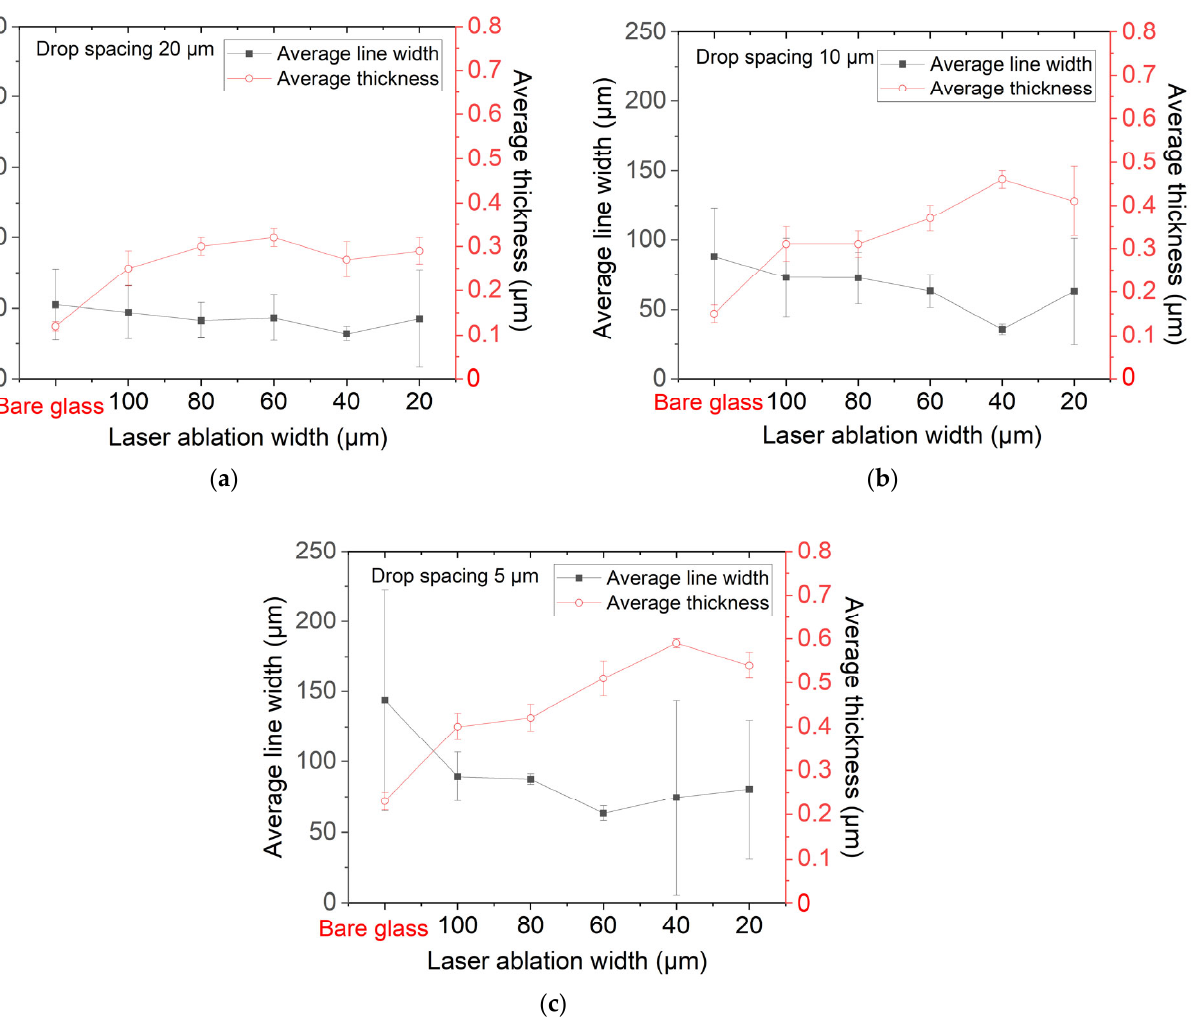
Figure 8. Variation in printed line width and thickness as a function of laser ablation width for inkjet drop spacing of ( a ) 20 µm, ( b ) 10 µm, and ( c ) 5 µm.